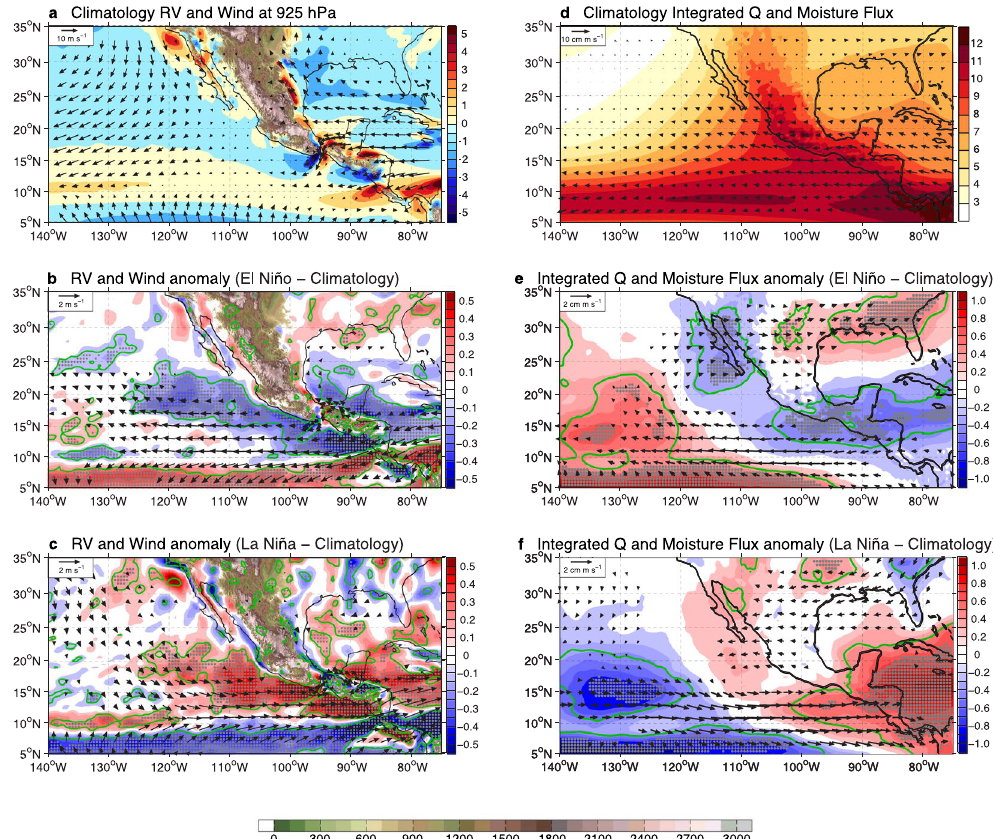
Figure 4. The impact of El Niño and La Niña on low-level relative vorticity and mid-level moisture. ( a ) Climatological, ( b ) the El Niño hurricane seasons and ( c ) the La Niña hurricane seasons composite minus climatology difference in relative vorticity ( rv ; shadings, unit: 10 − 5 s − 1 ) and wind vectors (unit: m s − 1 ) at 925 hPa. ( d ) Climatological, ( e ) the El Niño hurricane seasons and ( f ) the La Niña hurricane seasons composite minus climatology difference in 700 hPa through 500 hPa integrated specific humidity ( q ; shadings, unit: mm) and moisture flux ( q V ; vectors, unit: cm m s − 1 ). Gray dots (green contours) highlight the statistical confidence at the 95% (90%) level. All vector anomalies are plotted only where the confidence level is above 95%. Statistical significance test is performed based on the two-sample t-test. Land topography (unit: m) at atmospheric pressure level is shaded green-brown. The maps were generated using M_Map V1.4 package for Matlab (http://